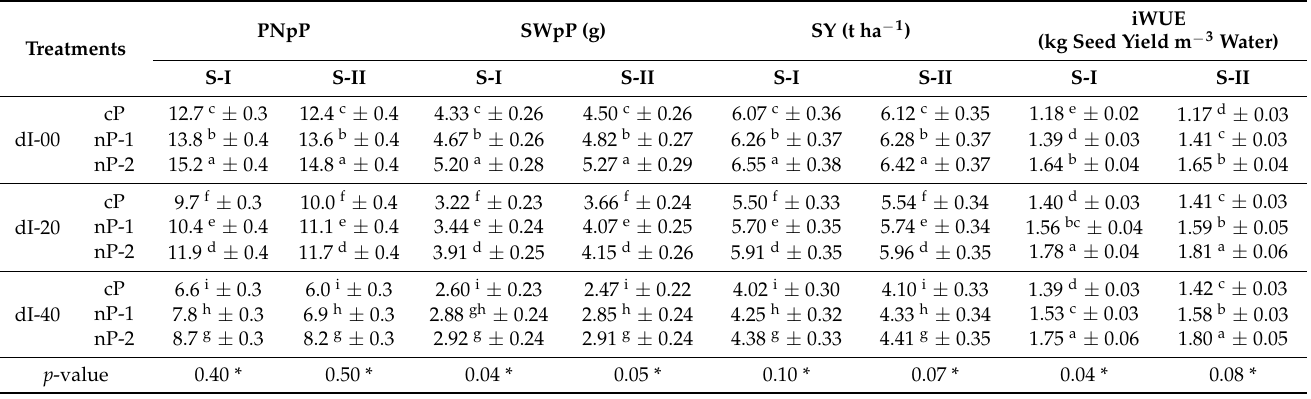
Table 4. Yield and yield components, and water use efficiency of fenugreek plants as affected by different irrigation water regimes and soil and foliar nourishing with phosphorus (P) during two growing